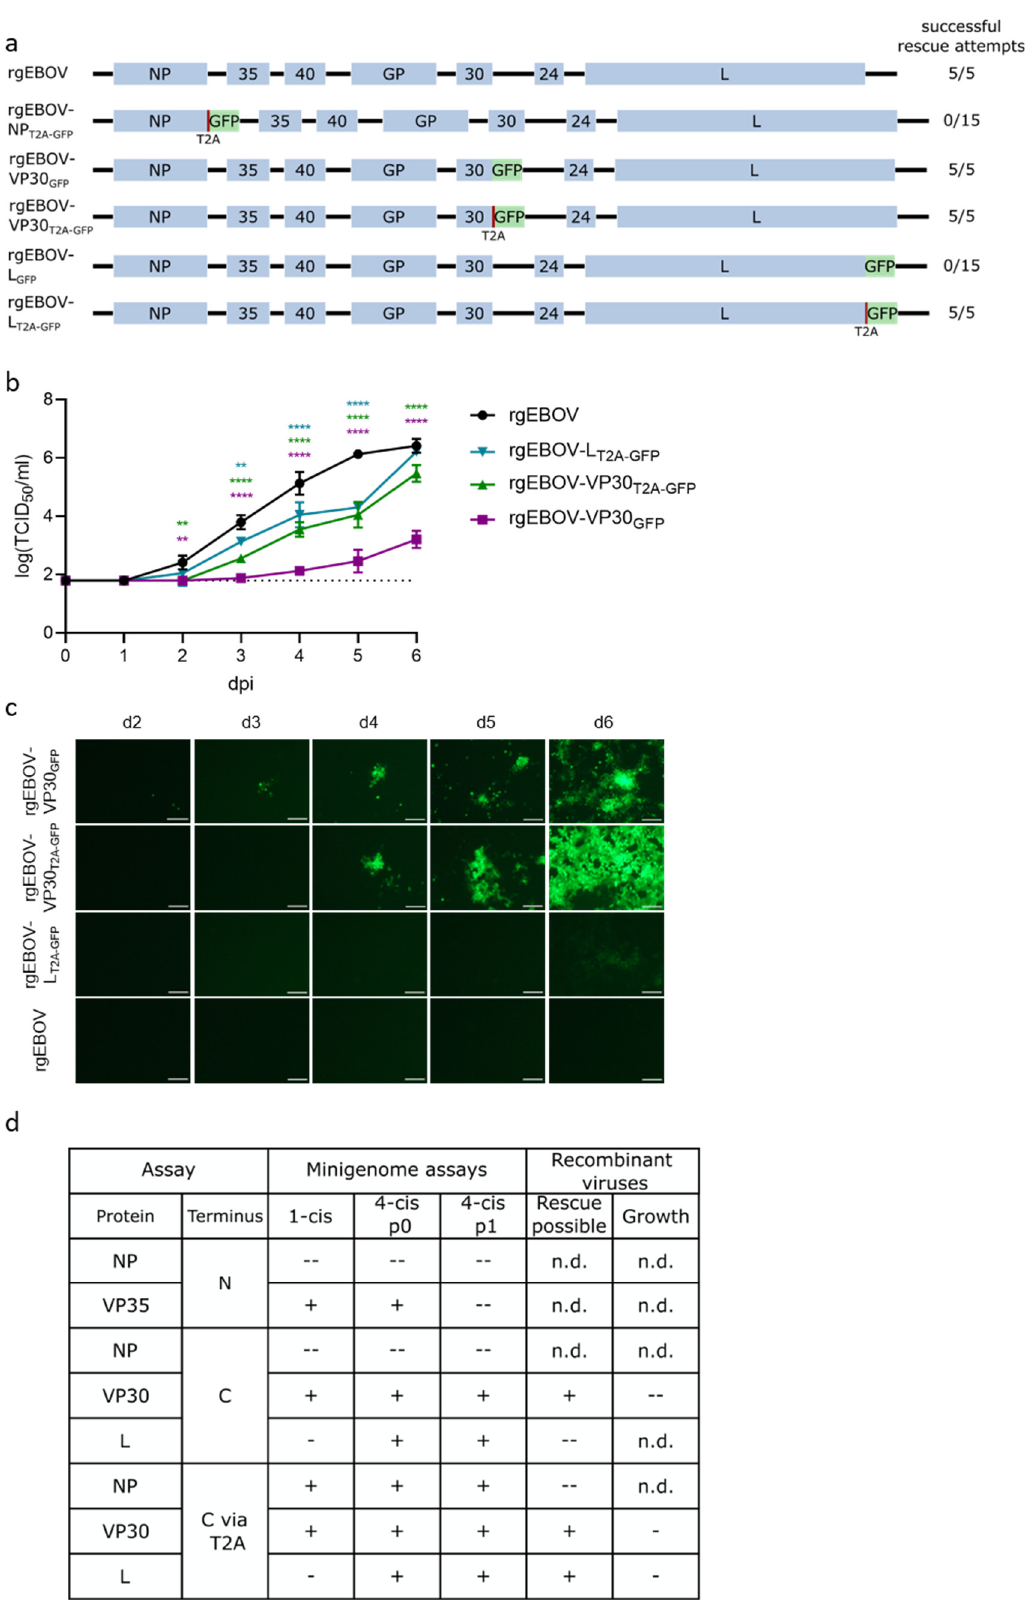
Figure 4. Characterization of GFP- and T2A-GFP-tagged recombinant EBOV. ( a ) Overview of genome structure of recombinant EBOV constructs encoding GFP as a reporter used for rescue attempts. ( b ) Growth kinetics of rescued viruses. 293T cells were infected with 1 × 10 4 TCID 50 of either GFP-tagged, GFP via a T2A-site tagged (as depicted), or untagged (rgEBOV) recombinant viruses.